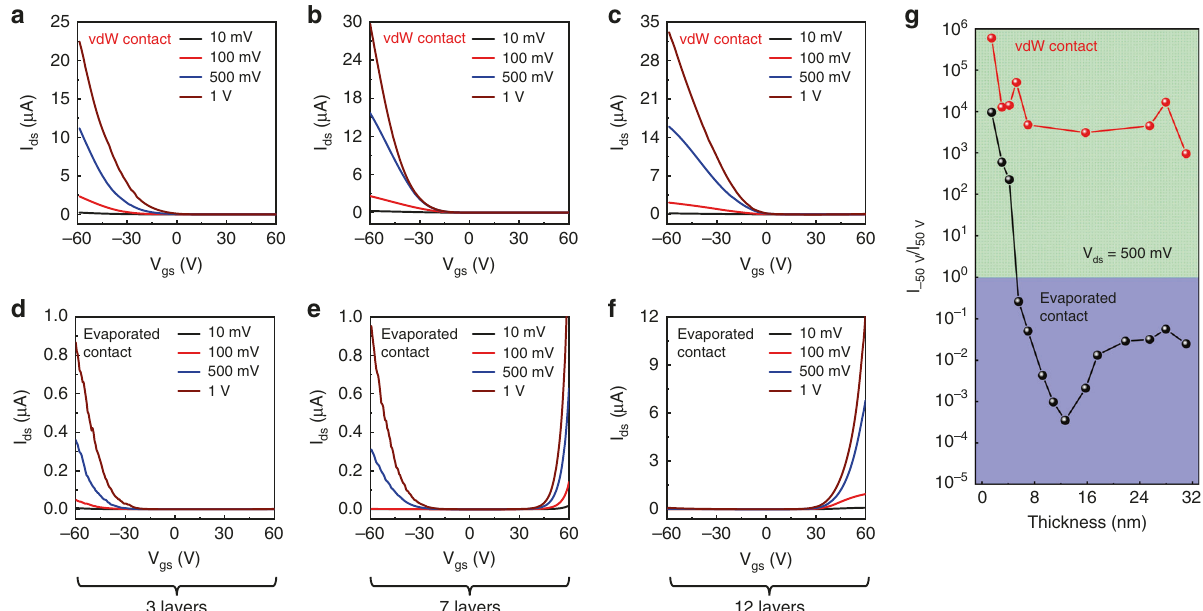
Fig. 2 Thickness-dependent electrical measurement of WSe 2 transistors with vdW-integrated and evaporated Au electrodes. a – c , I ds − V gs transfer curves of WSe 2 with different thicknesses (3 layers in a , 7 layers in b , and 12 layers in c ) using vdW Au electrodes, where p-type behavior is consistently observed. d – f I ds − V gs transfer curves of WSe 2 with different thicknesses (3 layers in d , 7 layers in e , and 12 layers in f ) using conventional deposited Au electrodes, where p-type, bipolar, and n-type behaviors are observed in d , e , and f , respectively. The V ds bias voltage is 0.01 V (black), 0.1 V (red), 0.5 V (blue), and 1 V (brown) throughout a – f . g The current ratio between I − 50V ( I ds at V g = − 50 V) and I 50V ( I ds at V g = 50 V) as a function of WSe 2 thickness. For devices with vdW electrodes, large I − 50V / I 50V ratio >10 3 is observed, suggesting the consistent p-type behavior, regardless of the channel thickness. For devices with conventional evaporated Au electrodes, I − 50V / I 50V is decreased with increasing body thickness, where a p-type to n-type transition is clearly observed. The V ds bias voltage in g is fi xed at 500